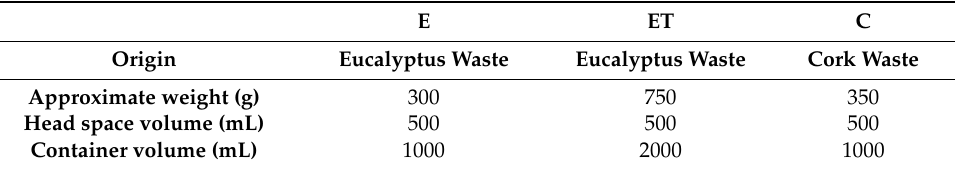
Figure 1. Samples in containers used for tests. Table 2. Sample features.